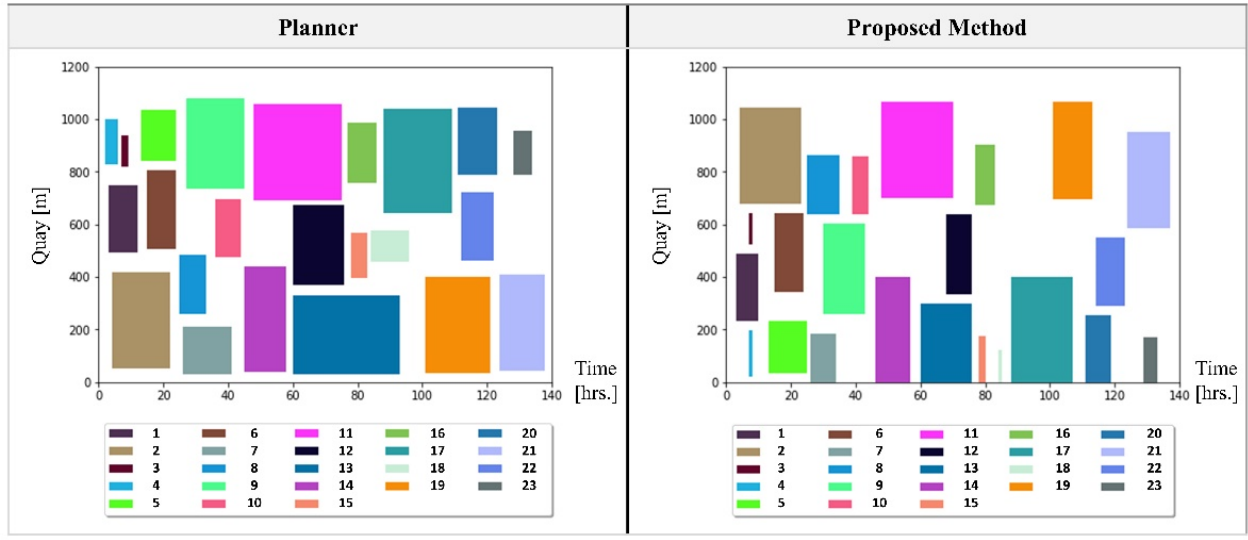
Figure 7. The result of Scenario 2.